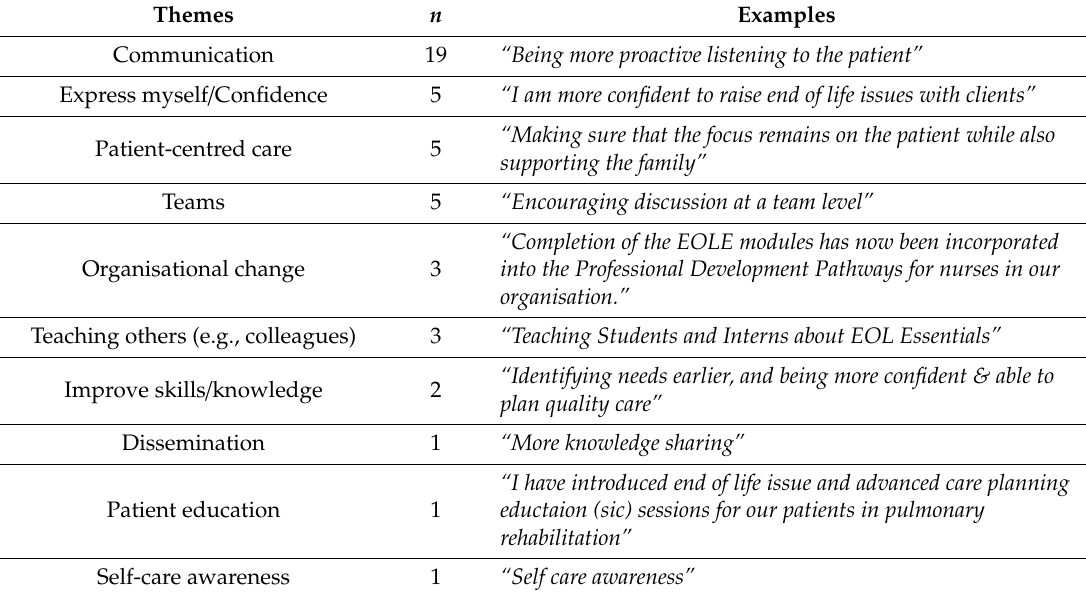
Table 3. Exemplars of learnings important to care categorized by